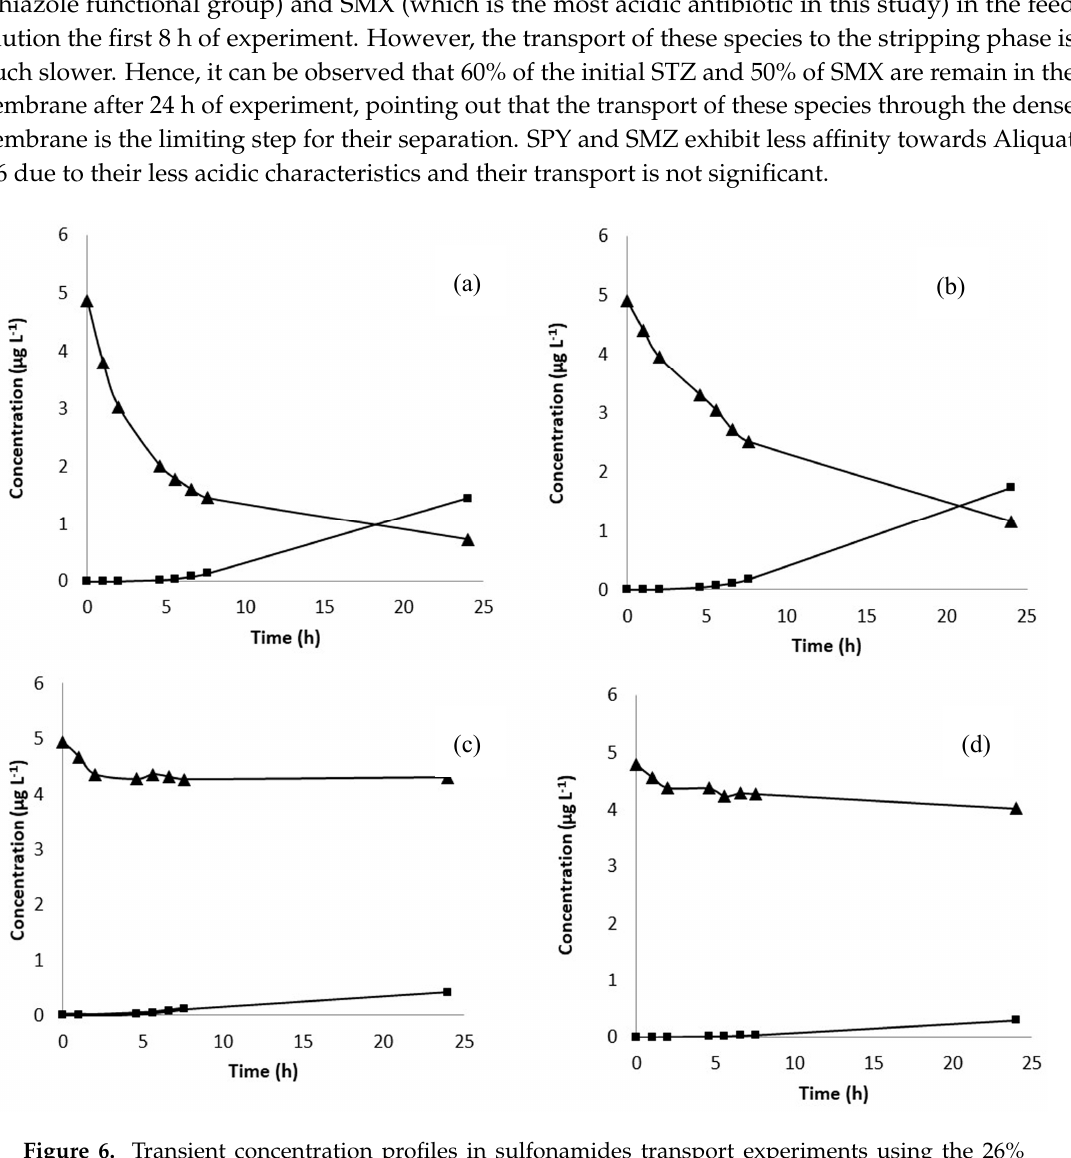
Figure 6. Transient concentration profiles in sulfonamides transport experiments using the 26% AlqCl/74% CTA PIM. ( a ) STZ; ( b ) SMX; ( c ) SPY; ( d ) SMZ. Triangles: feed solution; squares: stripping solution. (Feed solution: 5 mg L − 1 of sulfonamides at pH 9, stripping solution: 1 M NaCl).